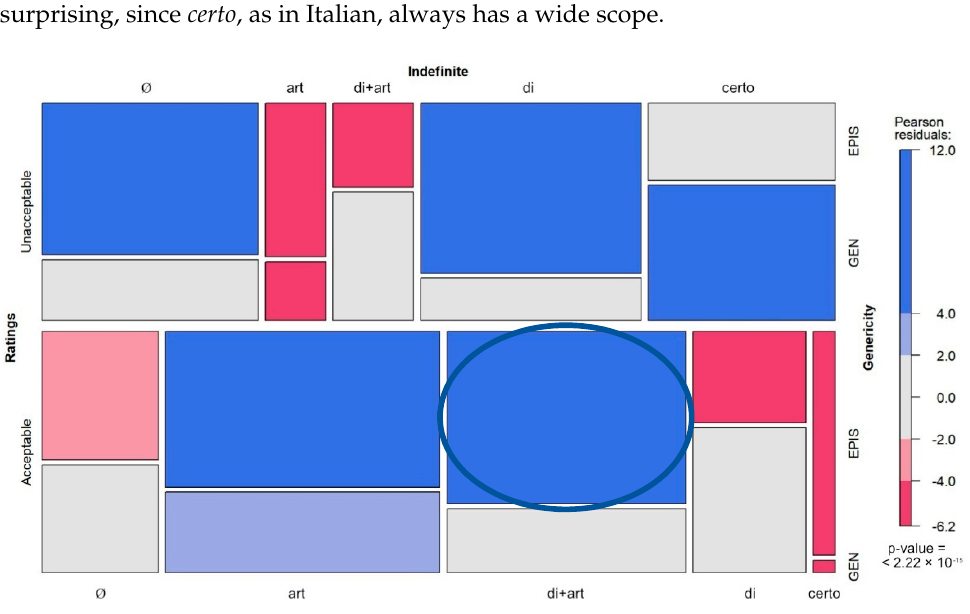
Figure 6. (Un)acceptability rate of each indefinite determiner with polarity. The red circle highlights the behavior of bare di , which is accepted only in negative sentences.